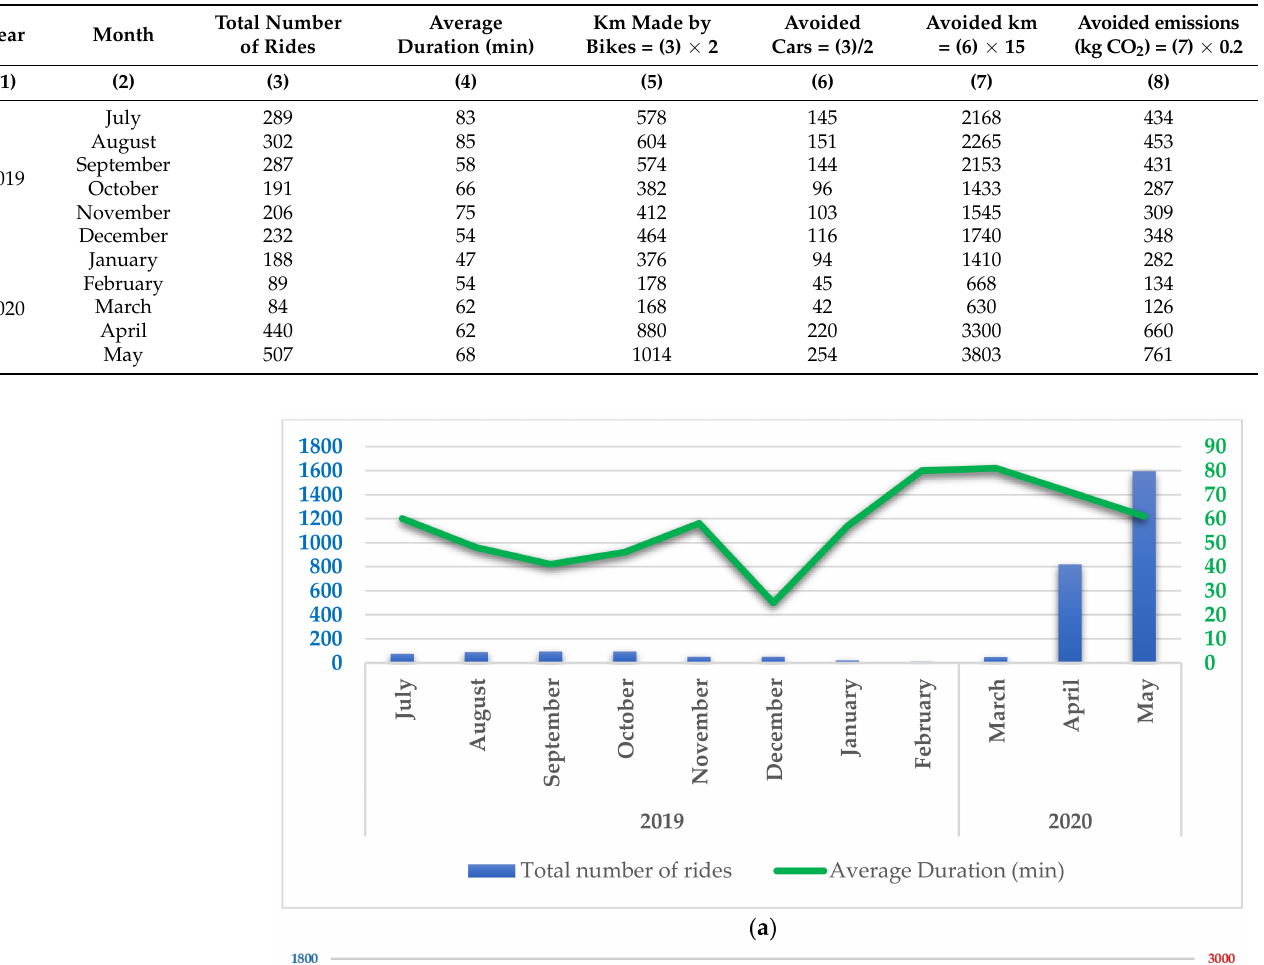
Table 7. Performance of Chania’s BS system using the SUMPORT KPIs (own process).